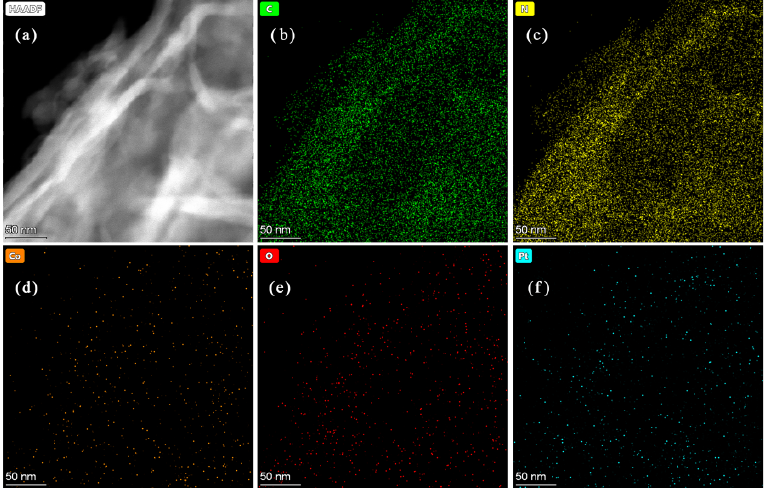
Figure 4. ( a ) HAADF-TEM image of Pt/0.5% Co 3 O 4 /g-C 3 N 4 . ( b – f ) Elemental maps of the catalyst: ( b ) C, ( c ) N, ( d ) Co, ( e ) O and ( f ) Pt elements.